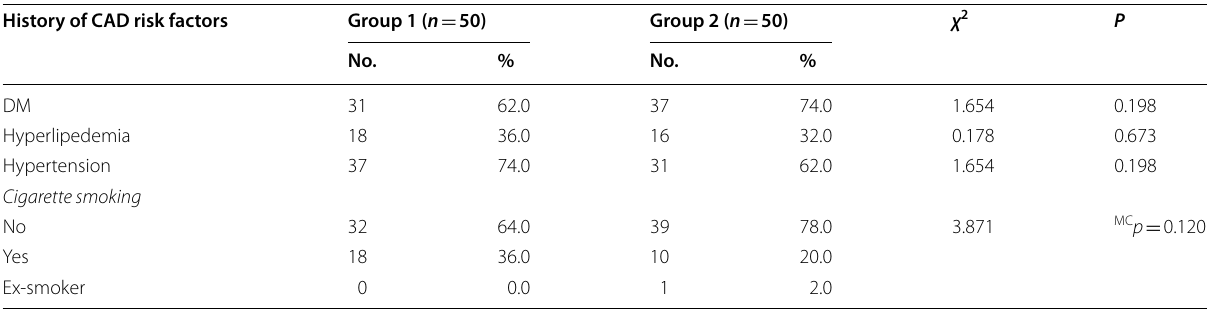
χ 2 Chi-square test, MC Monte Carlo, p p -value for comparison between the two studied groups, Group 1 patient treated with PCI and drug-eluting stents, Group 2 patient treated with CABG *Statistically significant at p ≤